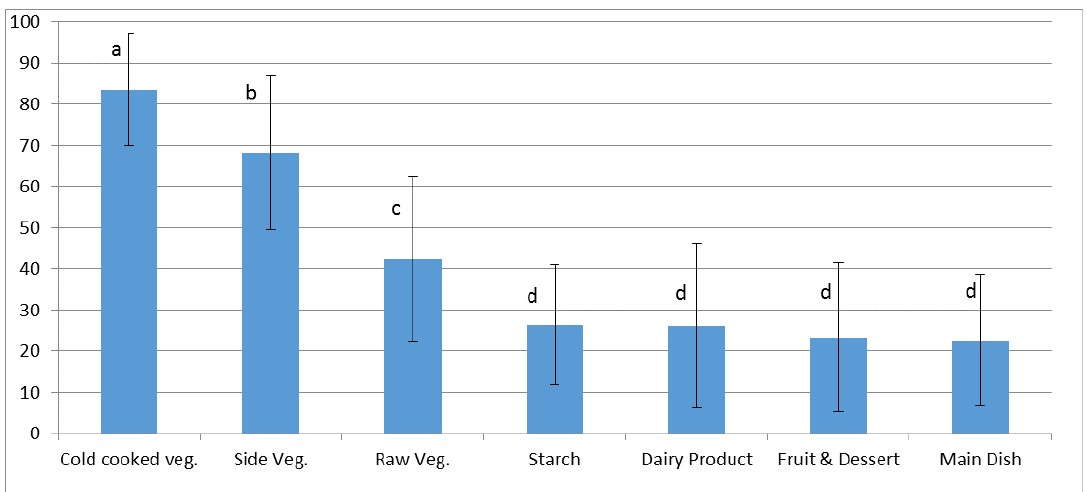
Figure 3. Mean rate of individual wastage of meal components (Error bars are standard deviations. Food with the same letter are not significantly different ANOVA 5% risk level).